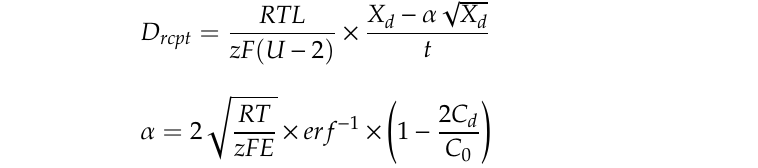
Figure 3. Results from chloride diffusion coefficient in various slime coating conditions. NB: Non- 170